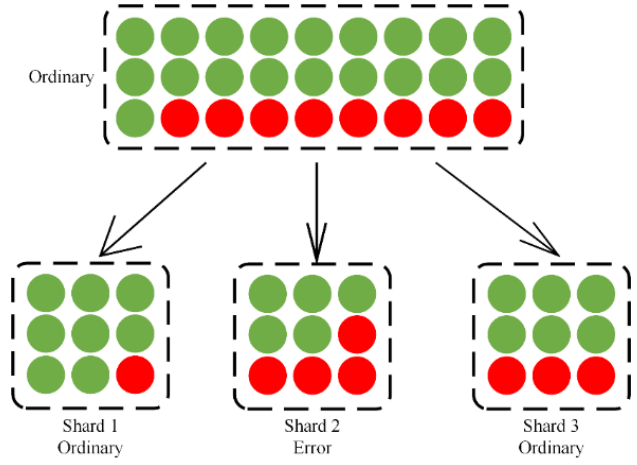
Figure 5. Risks of shard failure. Figure 5 shows that there is a certain probability that the proportion of Byzantine nodes in the shards will exceed 1/3 after sharding. In Figure 5, after the node assign- ment, the number of Byzantine nodes in shards 1 and 3 exceeds 1/3, resulting in a failure to reach a consensus within the shards. Section 4.2 discusses the relationship between the effectiveness of the intra-shard consensus and the number and size of the shards.